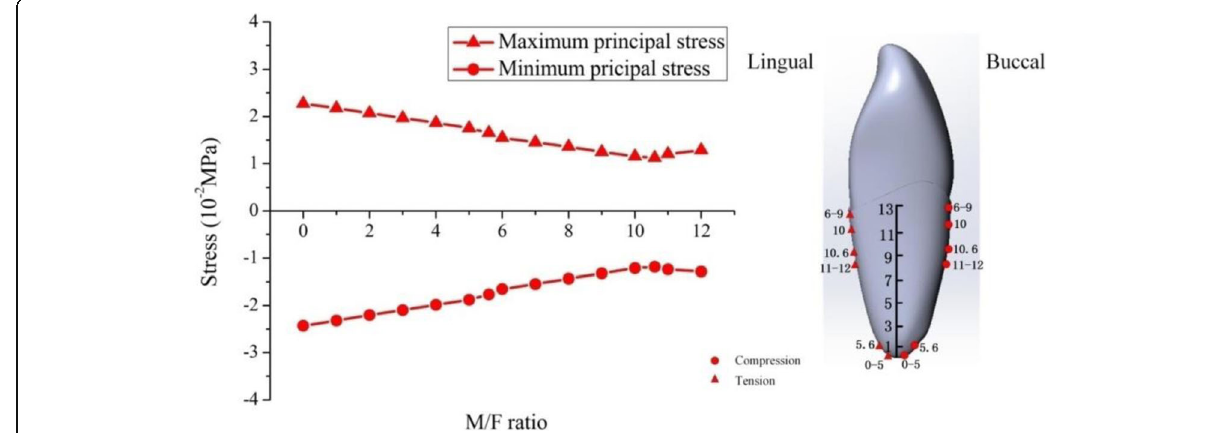
Fig. 6 Relationships between the M/F ratio(buccal-lingual direction) and principal stress for the model with bracket. Diagrams on the right show locations of maximum compressive and tensile